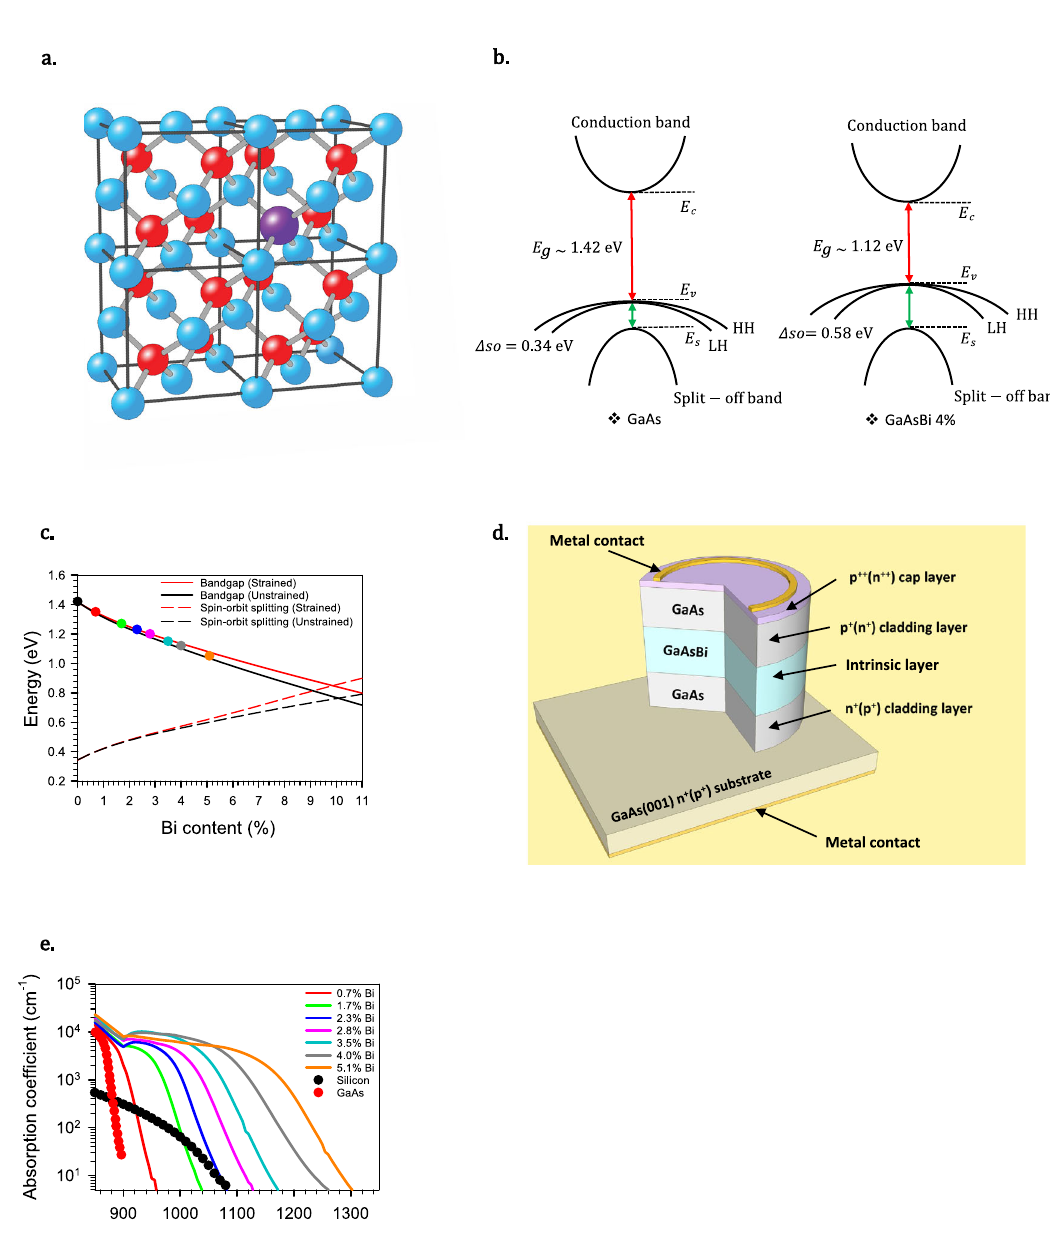
Fig. 1 Bi incorporation in GaAs and its effect on the opto-electronic properties. a A schematic showing Bi (purple) replacing As (red) in GaAs. b A simpli fi ed diagram of the effect of 4 % Bi on the energy bands of GaAs. c The bandgap energy and spin-orbit splitting energy of free-standing and strained GaAsBi calculated by Broderick et al 29 . The coloured dots represent the different Bi content samples characterized in this paper; data is also shown in Table 1. d Schematic cross-section of the p-i-n (n-i-p) device structures used in this investigation. e Absorption coef fi cient vs wavelength for a range of Bi contents compared to silicon 49 and GaAs 50